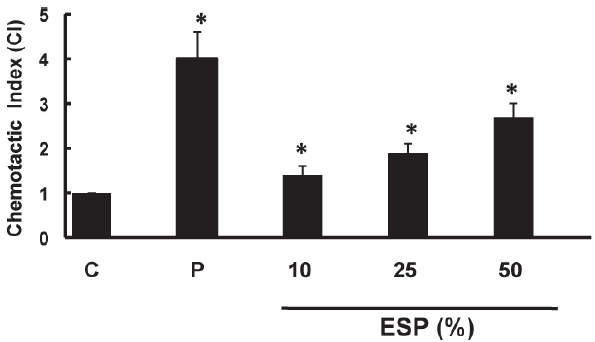
Fig. 4. – The migration of rat peritoneal mast cells was assessed by counting the number of RPMCs which migrated through the polycarbonate membrane after treatment with the excretory-secre- tory products (ESP) of T. vaginalis for 4 h. Stem cell factor (SCF) at 100 ng/ml was used as a positive control (P). C: RPMC alone. * p < 0.05 versus RPMC